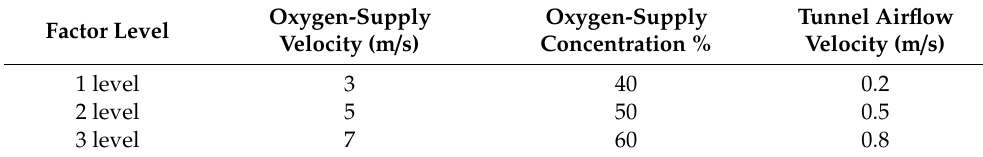
Table 2. Orthogonal factor level table.